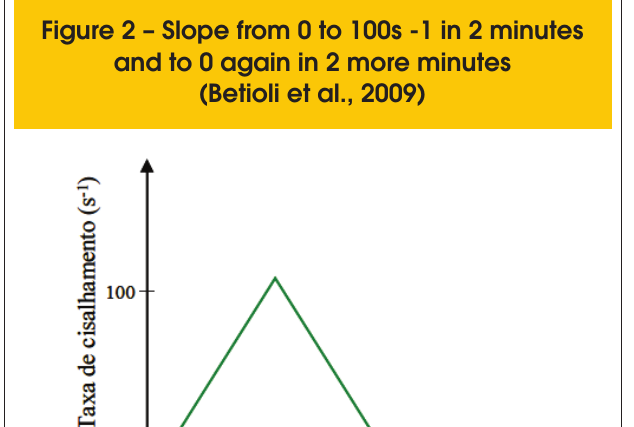
Figure 3 – Heat release rate during 6 hydration hours. The interval of induction period takes place between 20 and 110, approximately (Silva,